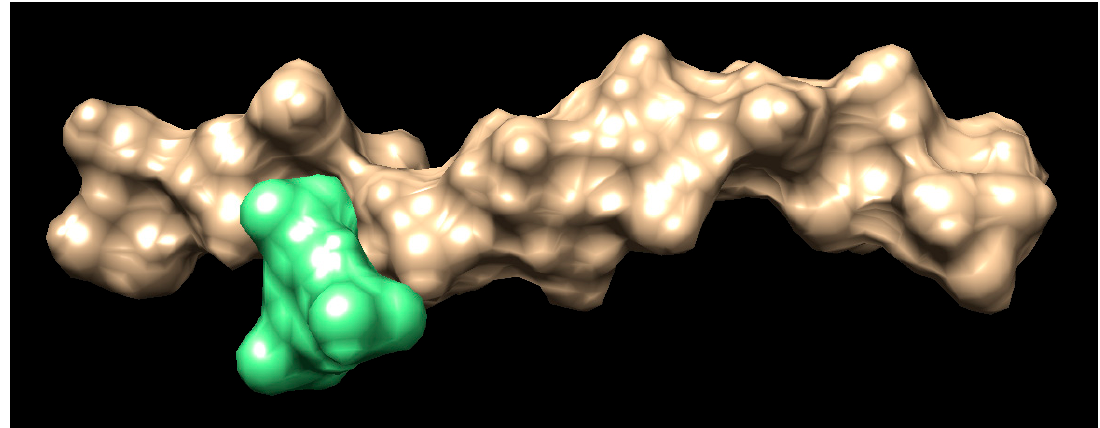
Figure 5. Docking pose (brown, chitosan; green, BTC docked).